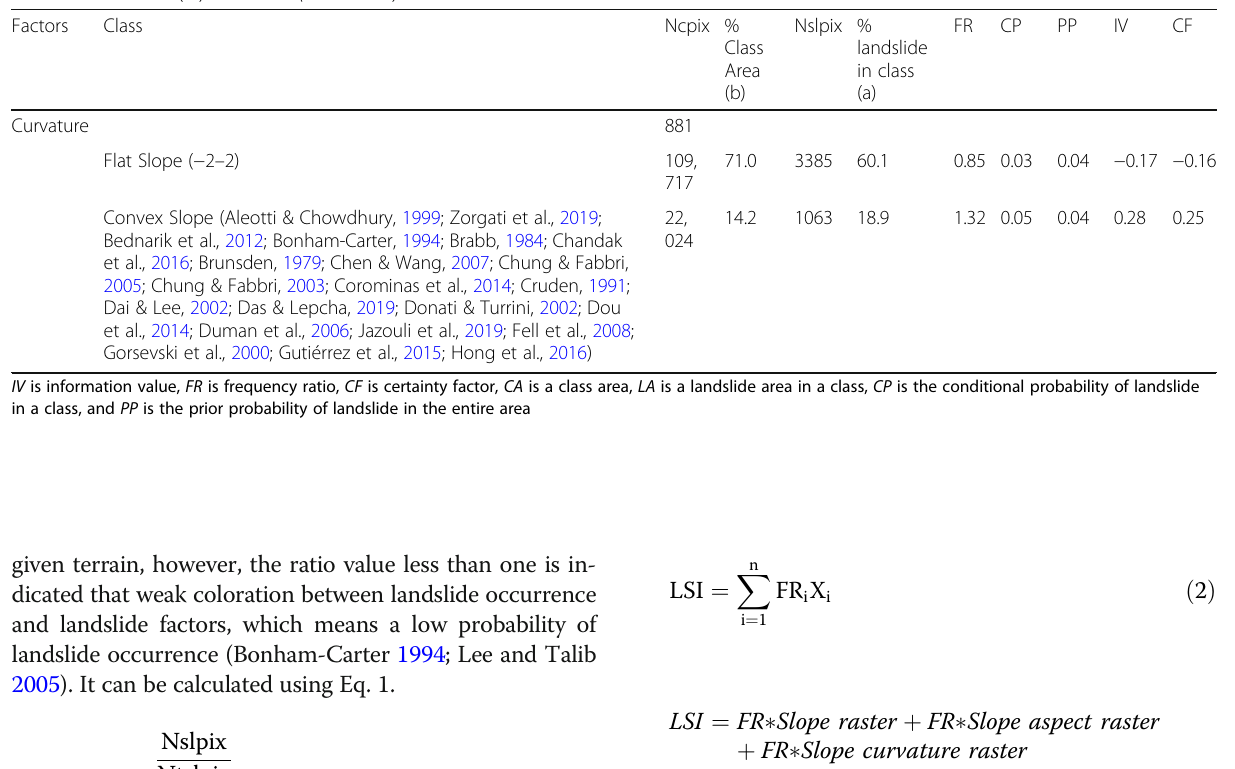
Table 2 Spatial relationship between each landslide factors and landslide using frequency ratio (FR), Certainty factor (CF) and information value (IV) methods